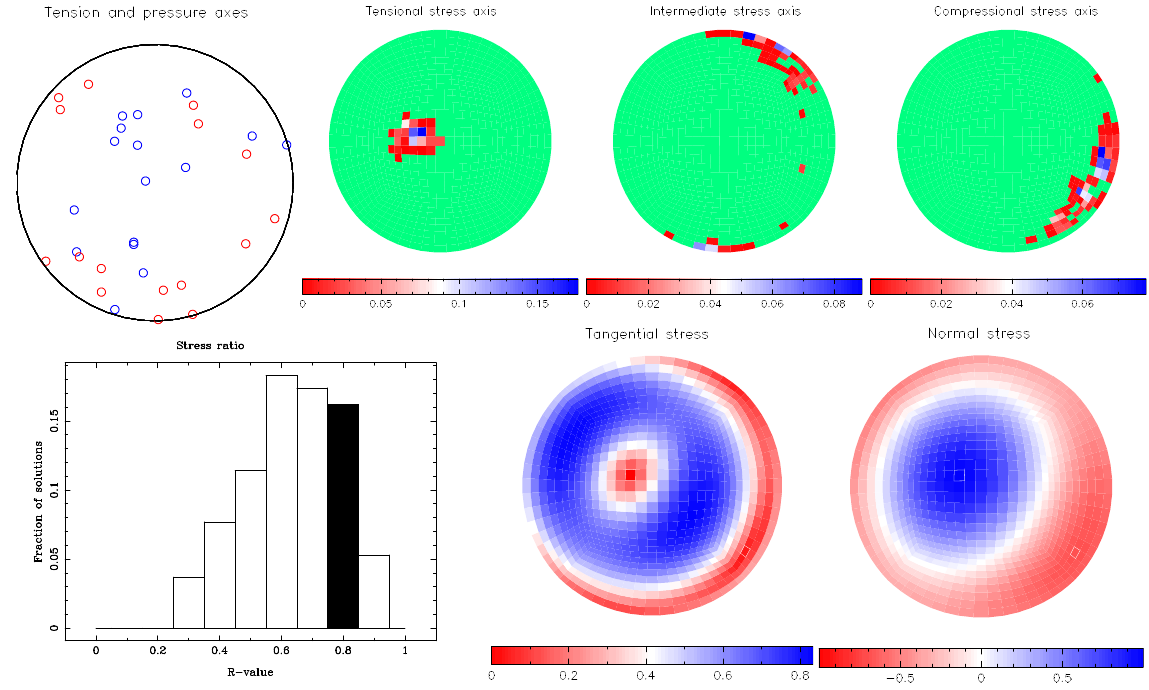
Fig. A7. Results of stress inversion for cluster of intermediate-depth earthquakes near Rhodos. Explanation of subfigures is as in Fig. 5.